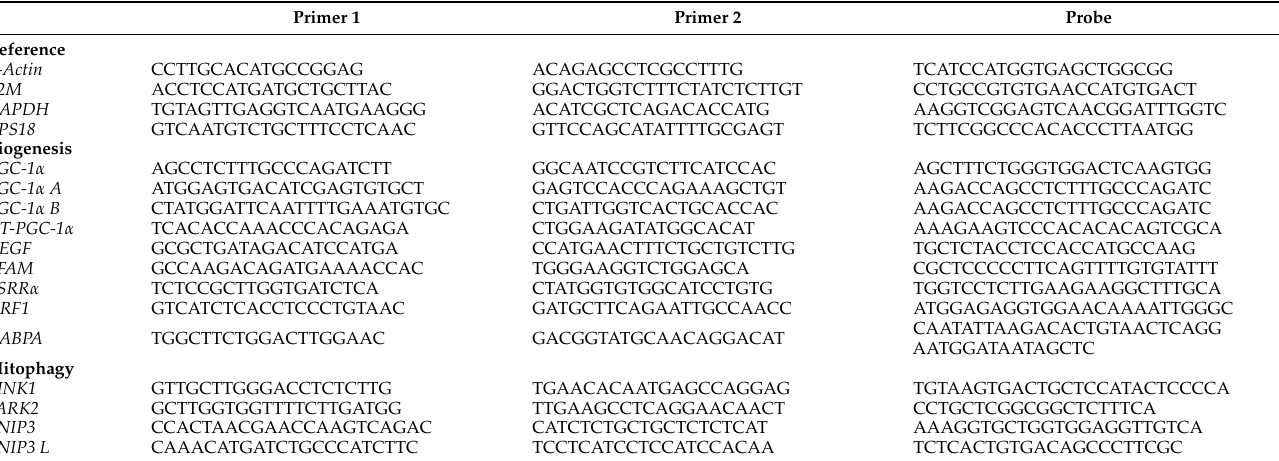
Table 1. Probes and Primers used for real-time reverse transcription quantitative